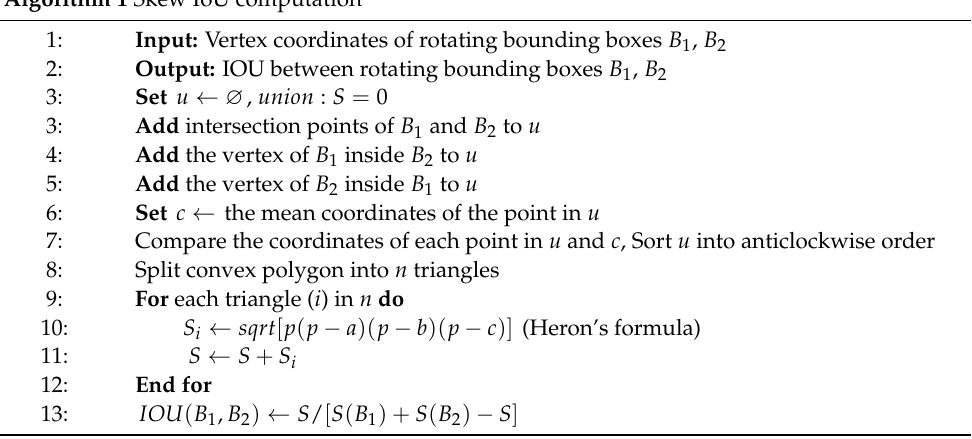
Algorithm 1 Skew IoU